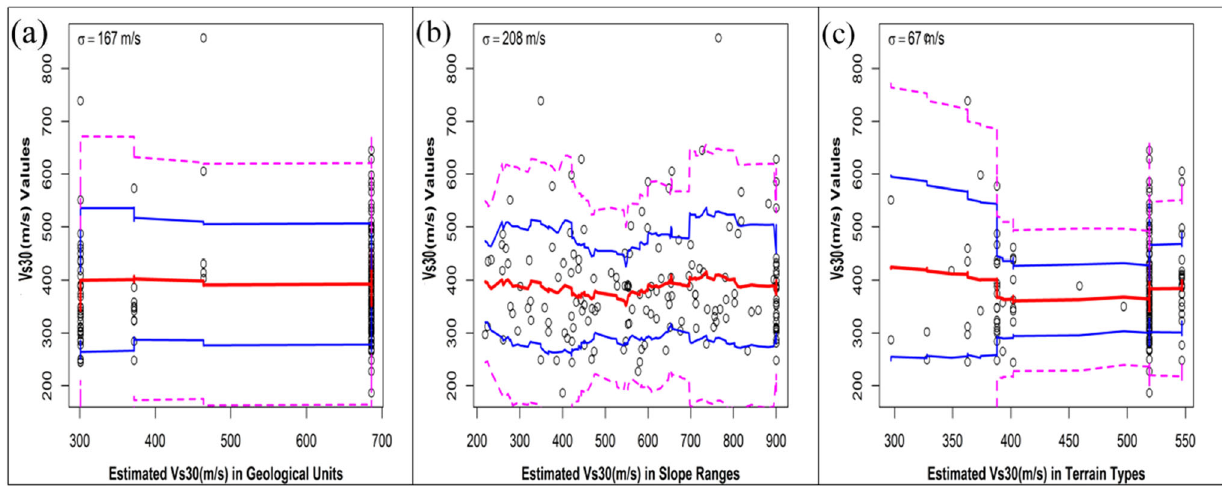
Fig. 5 Smoothed mean and standard deviation of estimated V s30 values using: a the geology-based approach; b the topographic slope- based approach; and c the terrain-based approach and measured V s30